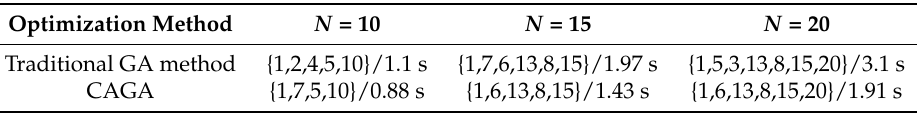
Table 2. Performance comparison of the